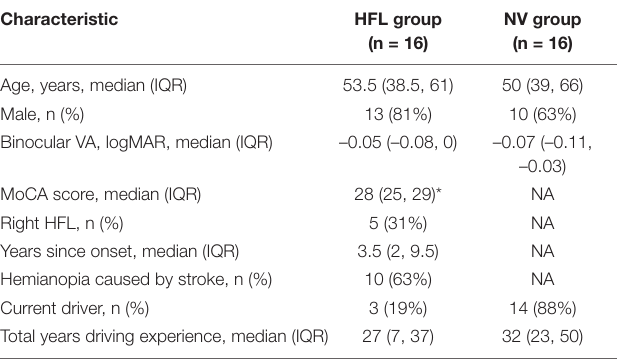
TABLE 1 | Characteristics of the 32 study participants in the analyses.